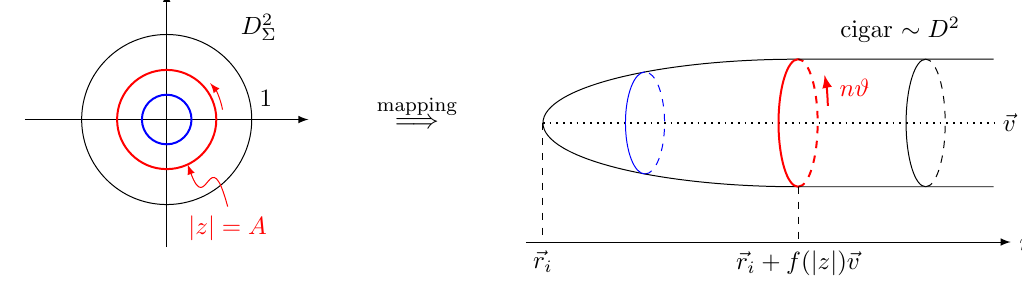
Figure 1 . A two-cycle de(cid:12)ned on the multi-centered Taub-NUT space.